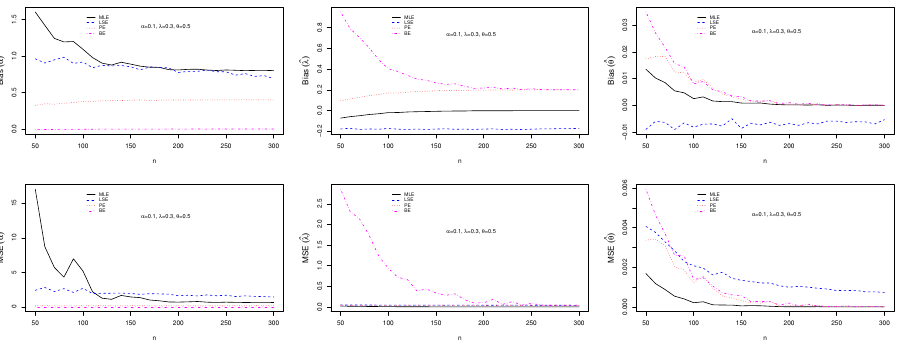
Figure 7. Plots of the bias and MSE for the different estimates of α = 0.1, λ = 0.3 and θ = 0.5.